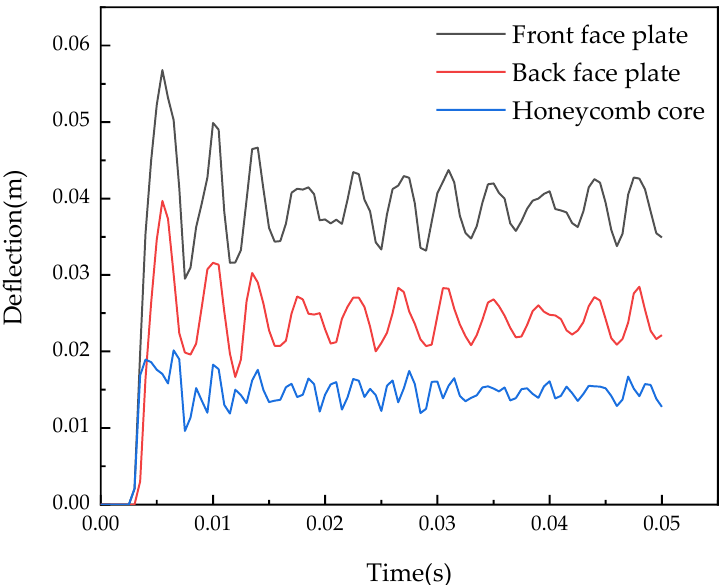
front face plate, back face plate, and honeycomb core, were selected to monitor their deflections, and the corresponding cures were plotted in Figure 11. It can be seen that the biggest deflection appears on the center of front face plate, whereas the back face plate has a smaller deflection. The honeycomb core crushing length, which is defined as the difference between the central points of the two face plates, has the smallest values.